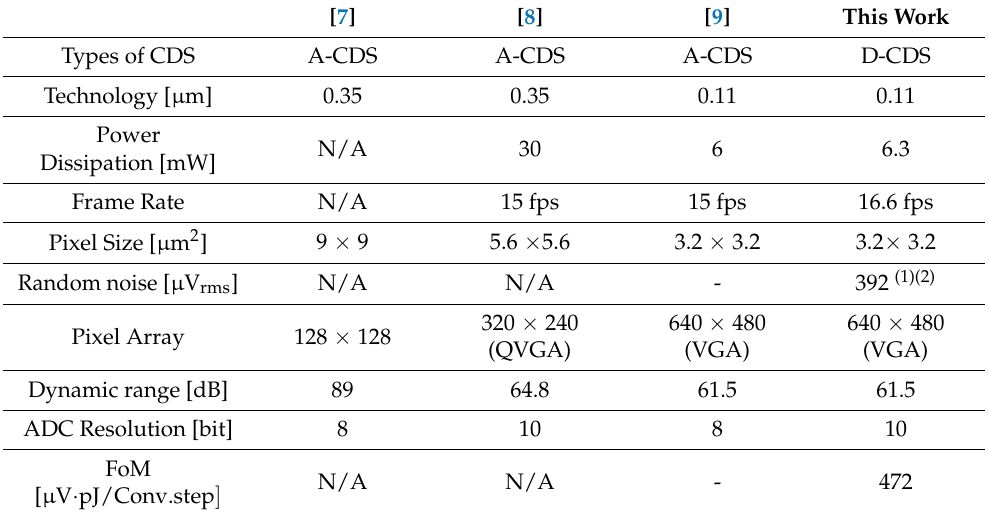
Table 2. Performance comparison; 1) measured with analog gain of 8; 2) input voltage range of ADC is 0.8 V.